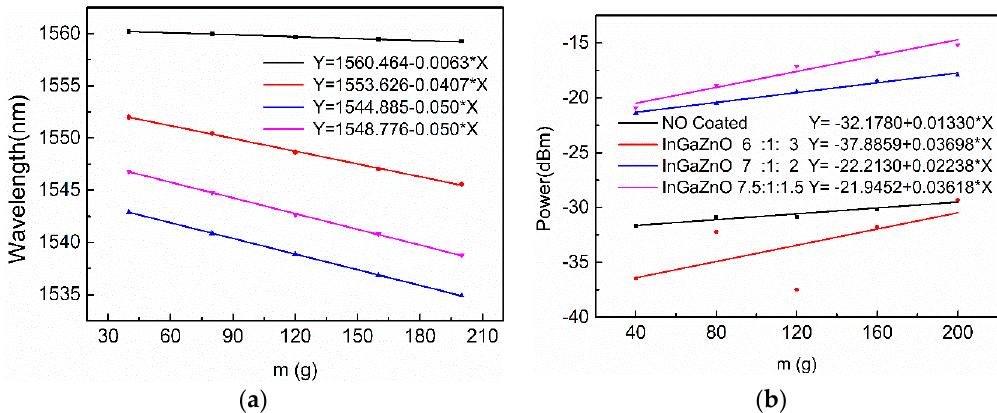
Figure 11. ( a ) Resonance wavelength of LPFG shifts with the mass of dissolved NaCl. ( b ) Resonance intensity of LPFG moves with the mass of dissolved NaCl.